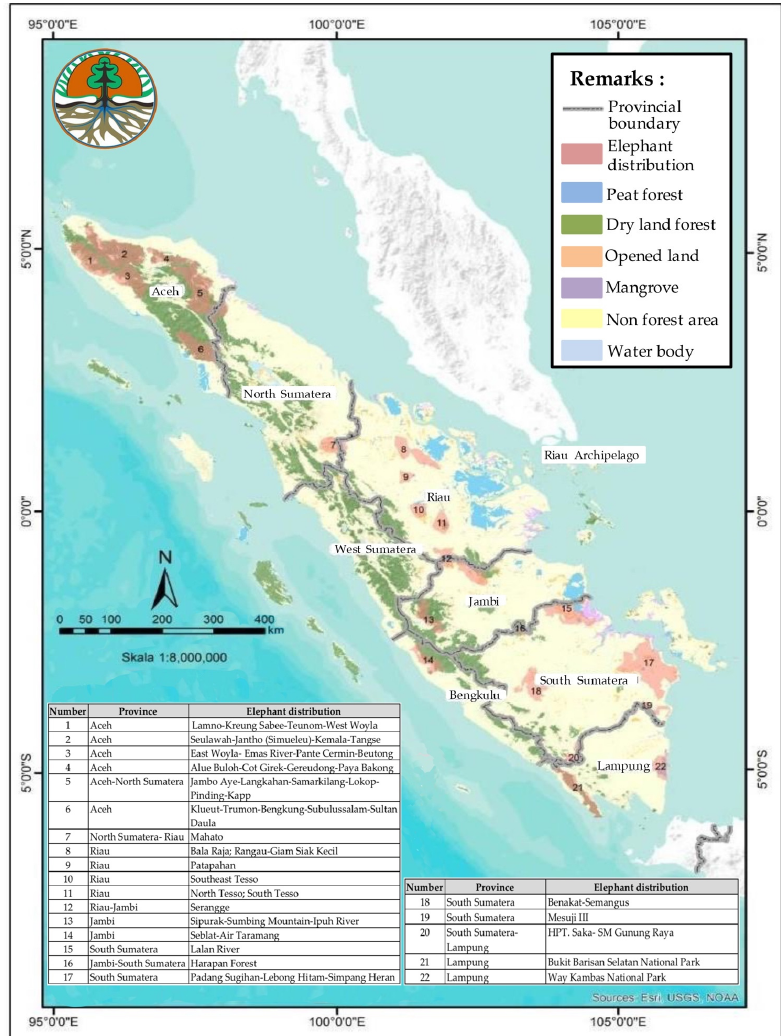
Figure 2. Source: Ministry of Environment and Forestry [40]. The distribution of Sumatran elephants on Sumatra Island.